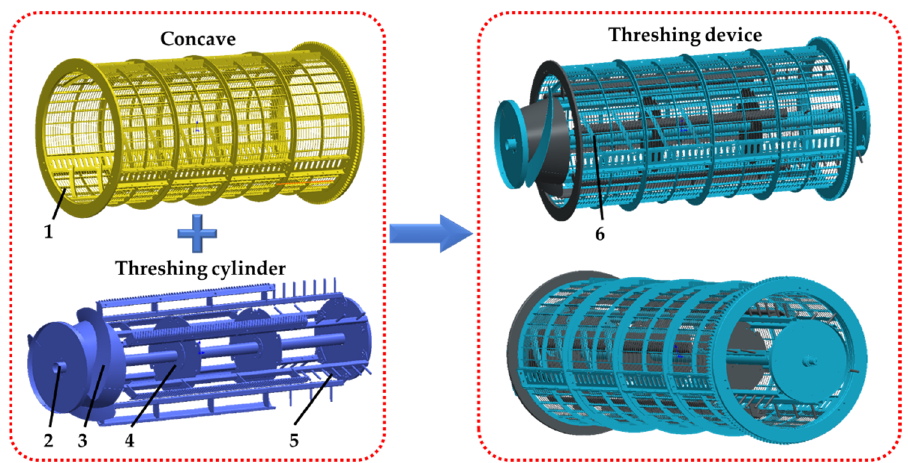
Figure 3. Structure of oilseed rape threshing device. 1—concave; 2—shaft; 3—screw feeding head; 4—spreading disc; 5—threshing elements; 6—guide plate angle.